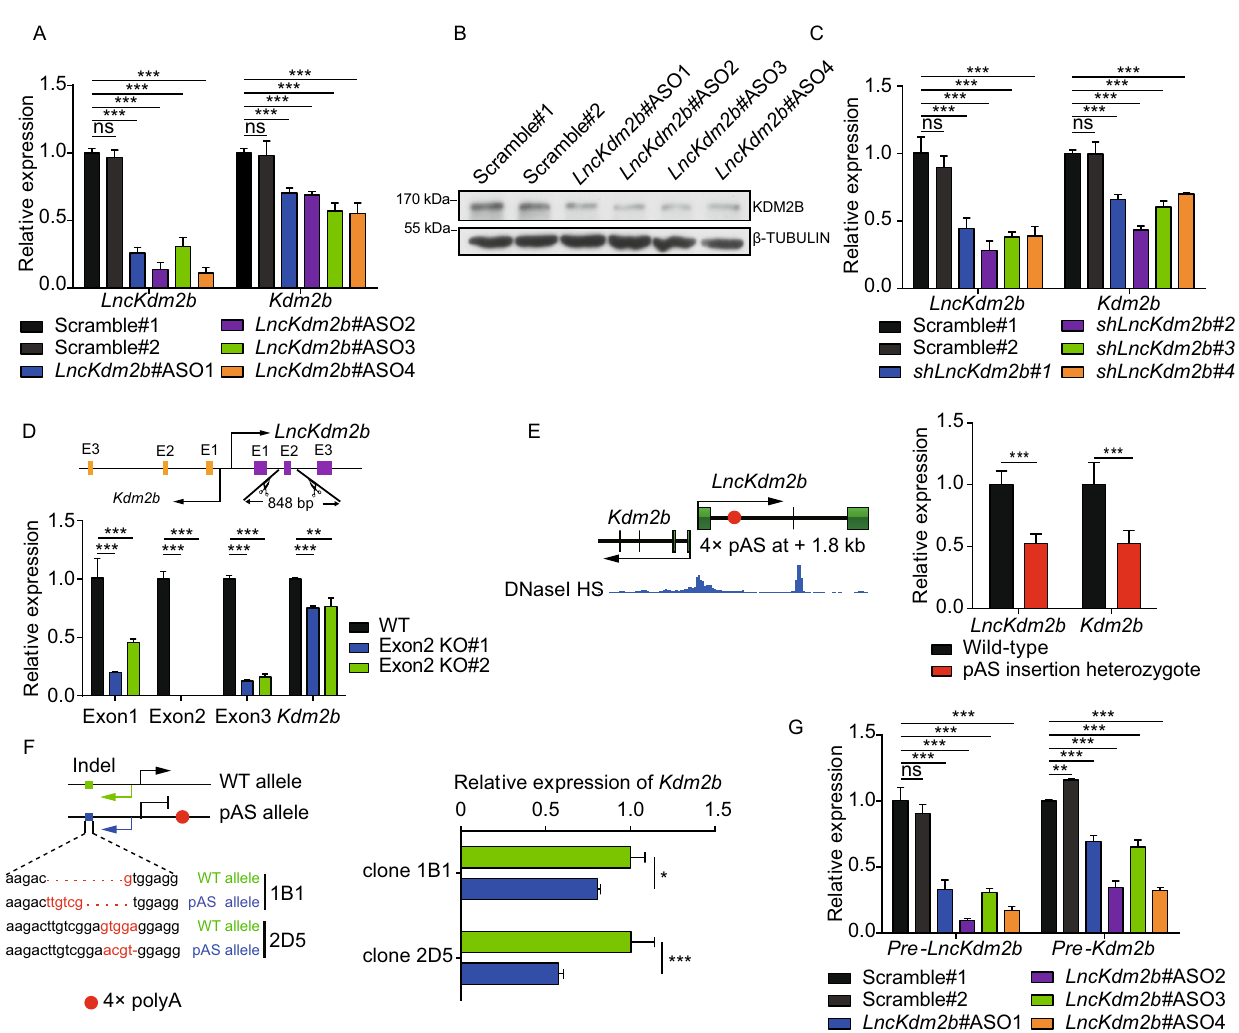
Figure 2. LncKdm2b maintains Kdm2b transcription in cis . (A) RT-qPCR analysis of LncKdm2b and Kdm2b RNA levels in Neuro-2a cells treated for two days with Scramble ASOs or ASOs targeting LncKdm2b . (B) Representative immunoblotting of